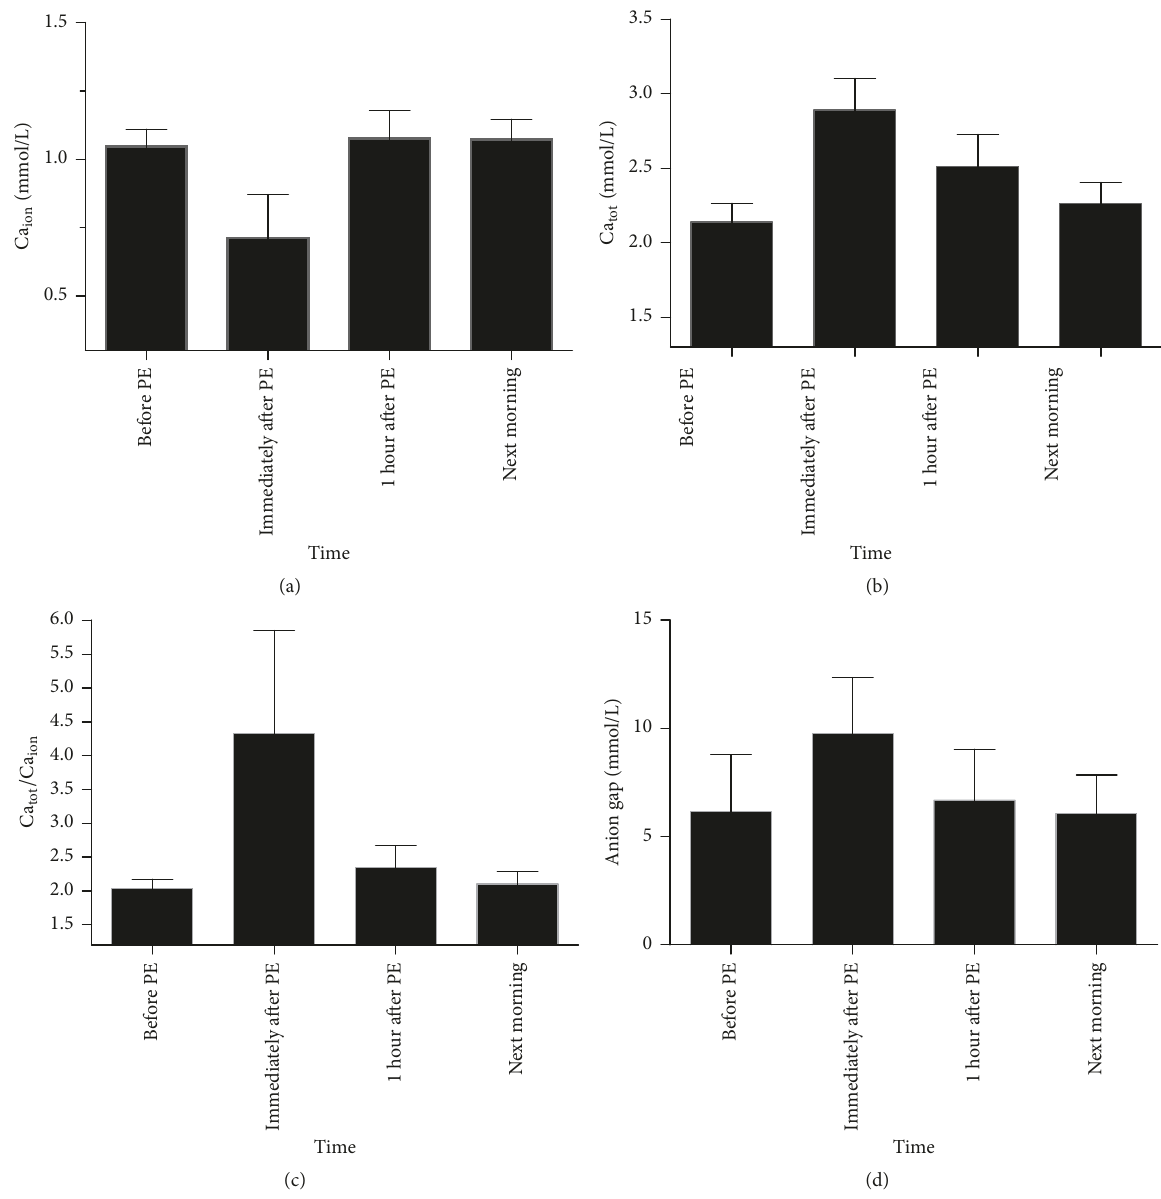
Figure 3: Trends of ionized calcium (Ca ion , (a)), total calcium (Ca tot , (b)), total-to-ionized calcium ratio (Ca tot / Ca ion , (c)), and anion gap (d) during and after ALSS therapy for patients with